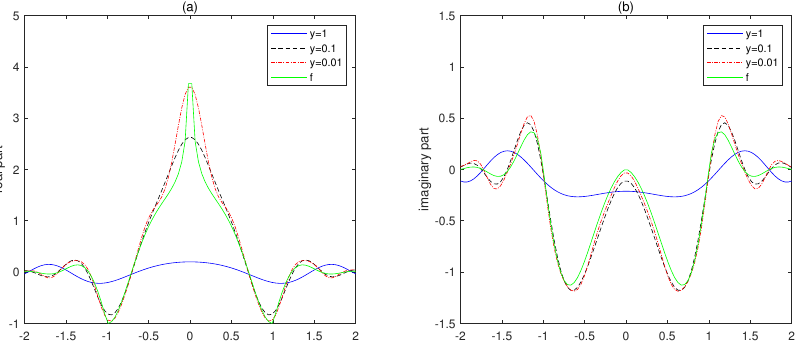
Figure 4. ( a ) Real part graph for comparison, ( b ) Imaginary part graph for